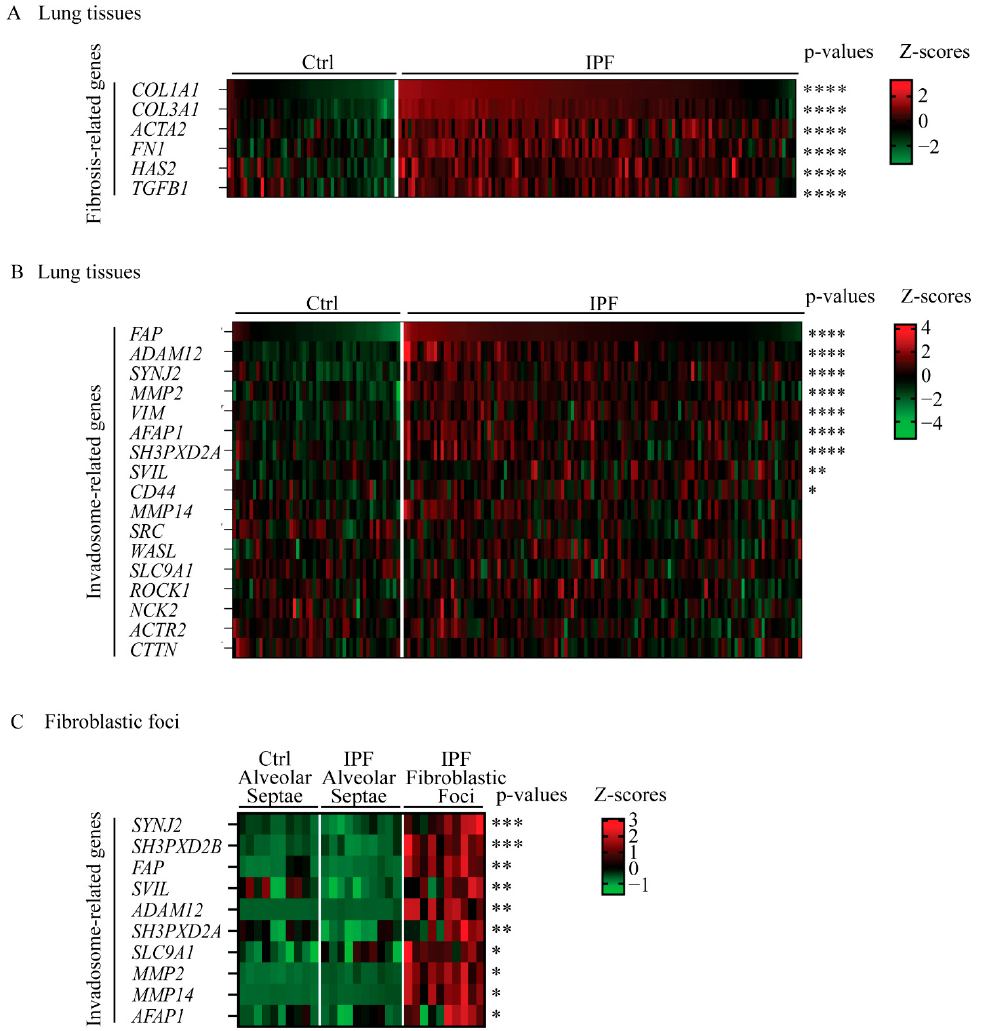
Figure 1. Several invadosome-associated genes are increased in lungs from IPF patients. Heatmaps of differential expression analysis using public datasets. Expression levels are presented as Z-scores. Significance of each gene is shown on the left with Benjamini–Hochberg false discovery rate ad- justed p -values. Gene expression in lung tissue from GSE32537 of ( A ) 6 fibrosis-associated genes and ( B ) 17 genes encoding proteins involved in invadosome formation. Ctrl ( n = 50) and IPF ( n = 119). ( C ) Gene expression from GSE169500 of 10 genes involved in invadosome formation. Control alveolar septae ( n = 10), IPF alveolar septae ( n = 10) and IPF fibroblastic foci ( n = 10). * p < 0.05, ** p < 0.01, *** p < 0.001, **** p < 0.0001. 2.2. Invadosome Formation Is Increased in Lung Fibroblasts Isolated from IPF Patients and Fibrotic Mice To assess the ability of IPF fibroblasts to form ECM-degrading invadosomes, we iso- lated lung fibroblasts from healthy and IPF lung tissues, and the cells were subjected to